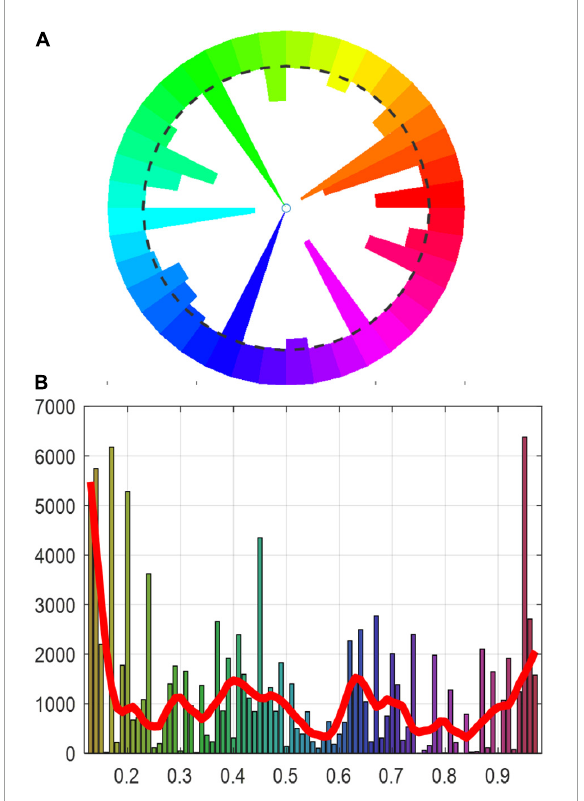
FIGURE7 Hue histogram of Cave 465, Mogao Grottoes. (A) Hue polar histogram, (B) LOWESS plot of the hue histogram.